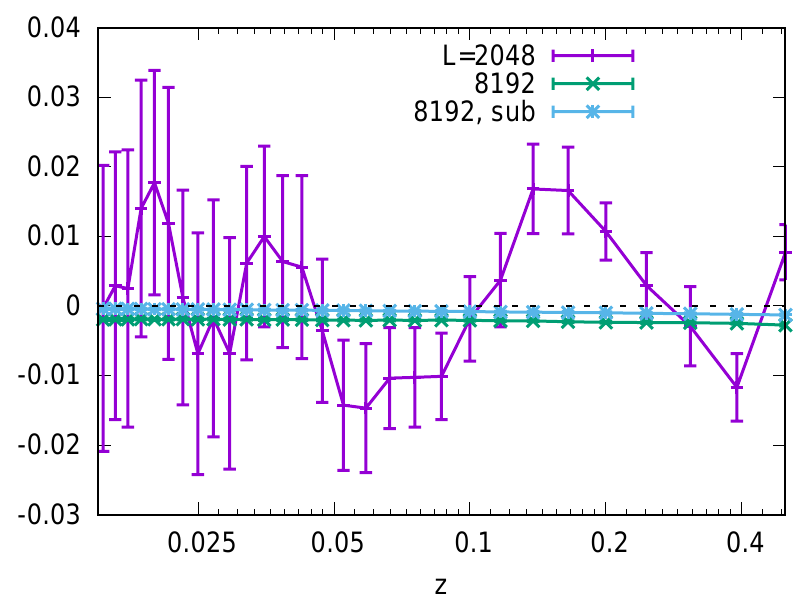
Figure A.9: Q = 3 comparison between Monte-Carlo measurements and exact results for L = 2 11 , L = 2 13 , and L = 2 13 with subleading topological corrections factored in. Relative differences are plotted as functions the